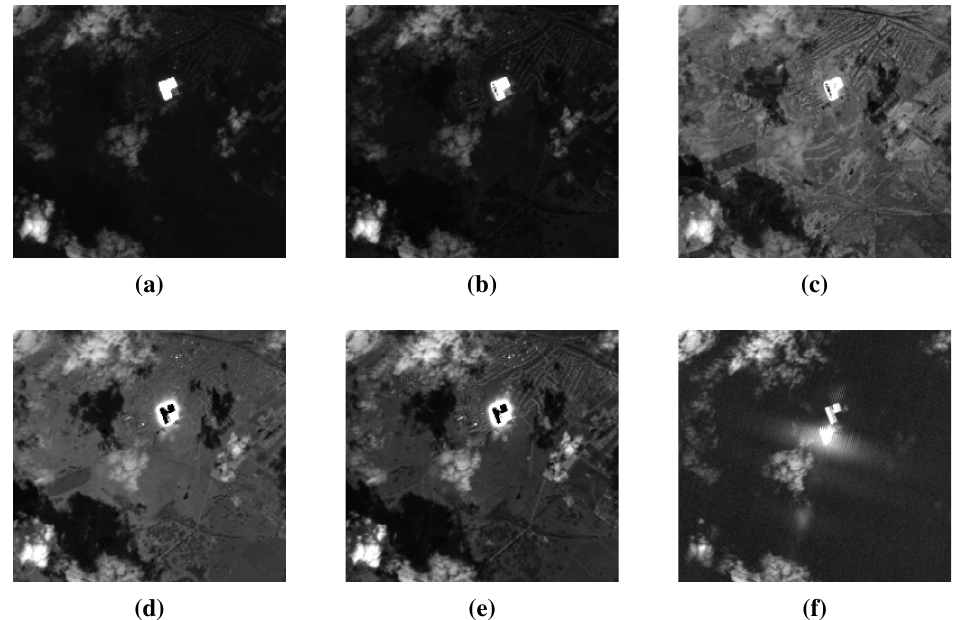
Figure 14. Large greenhouse complex in Novosibirsk region in Russia showing the effect of detectors pushed well beyond saturation. In the visible, red, and near infrared bands ( a )–( c ), the instrument responds more typically to the bright target with only a few pixels in the red and NIR bands oversaturated. In the ( d ) SWIR 1 and ( e ) SWIR 2 bands, the specular reflectance of the greenhouse saturates the detectors and the instrument produces DN values of zero. As soon as the detectors view more normal radiance levels, the response returns to normal saturation, as shown by the bright ring around the dark roof. The ( f ) cirrus band exhibits additional stray light